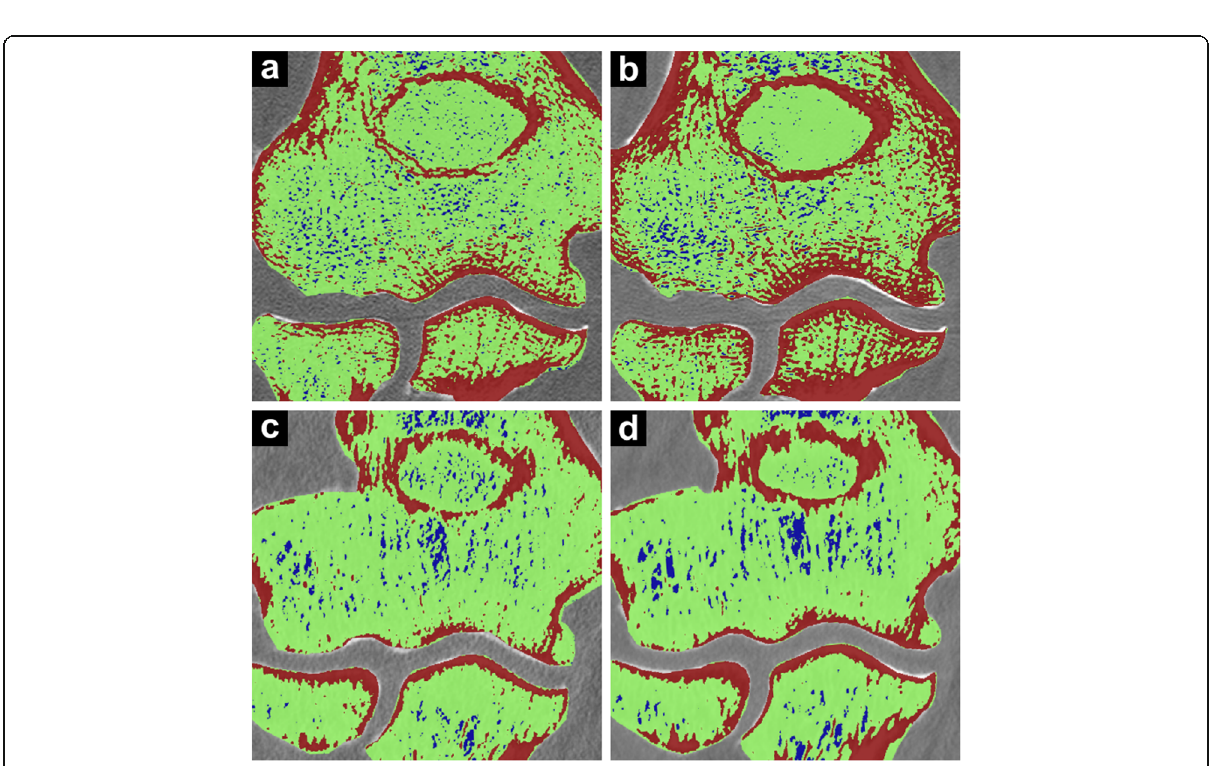
Fig. 5 Colour-coded visualisation of signal intensity distribution in cancellous bone for cone-beam computed tomography (CBCT) and multidetector computed tomography (MDCT) scans. Red regions contain the maximum quartile of grey values (75 – 100%), while blue regions represent the minimum quartile (0 – 25%). Green regions consist of pixels with intermediate signal intensity (25 – 75%). a Low-dose CBCT. b Regular-dose CBCT. c Low-dose MDCT. d Regular-dose